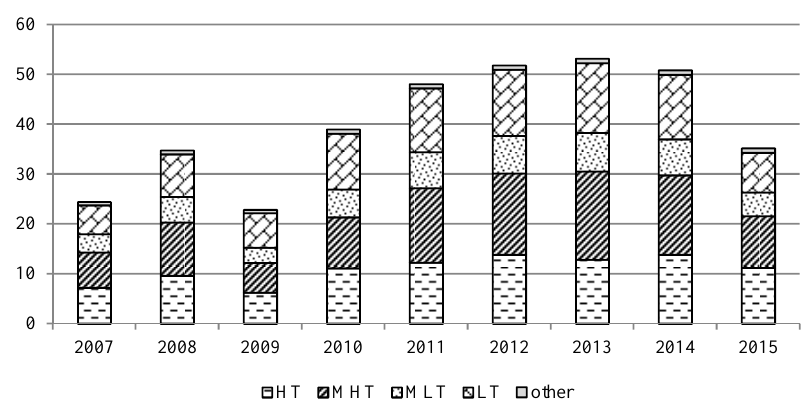
Figure 4. Goods structure of Russian imports from China in 2007–2015 (billion USD)